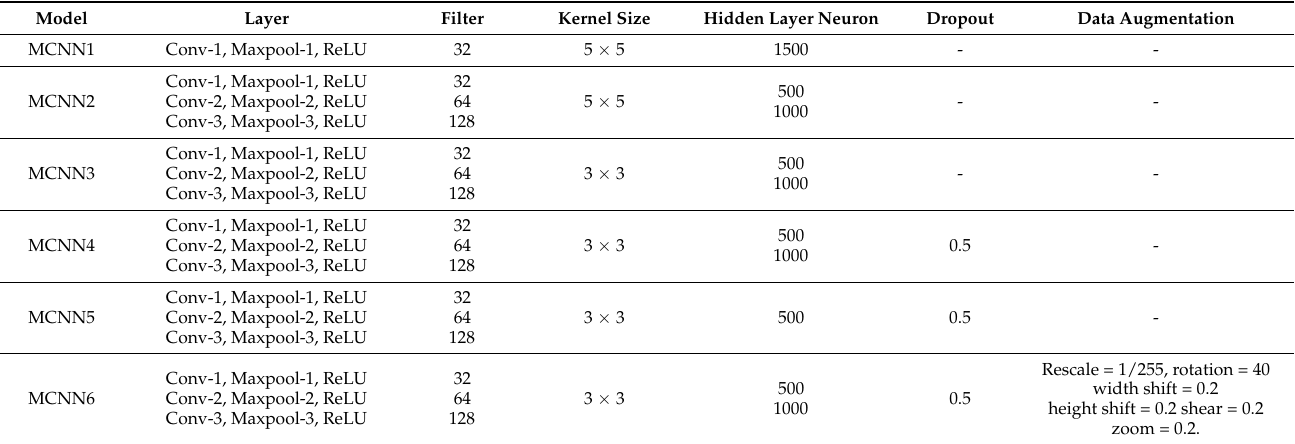
Table 1. Six architectures based on